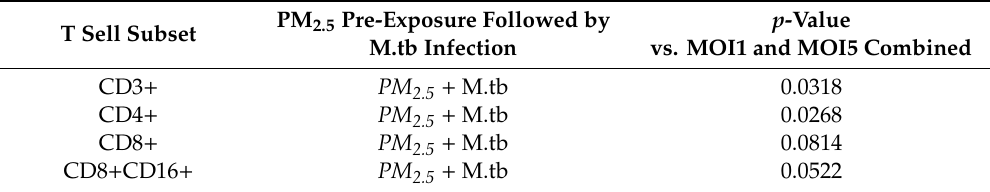
Table 2. PM 2.5 exposure reduces M.tb-induced IFN- γ expression in T-cell subsets of PBMC.